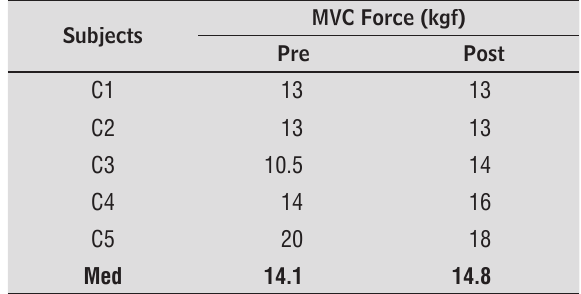
Table 1 - CG Muscle Strength before and after training